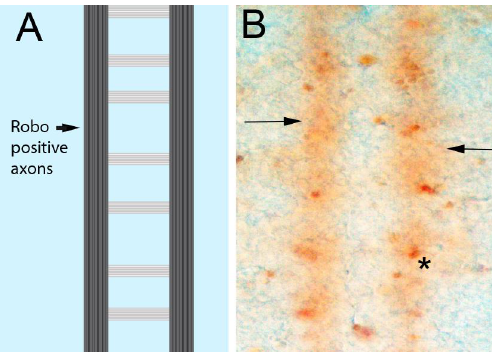
Figure 3. Low-level caspase activity in longitudinal axons. ( A ) Schematic of the CNS axon scaffold in